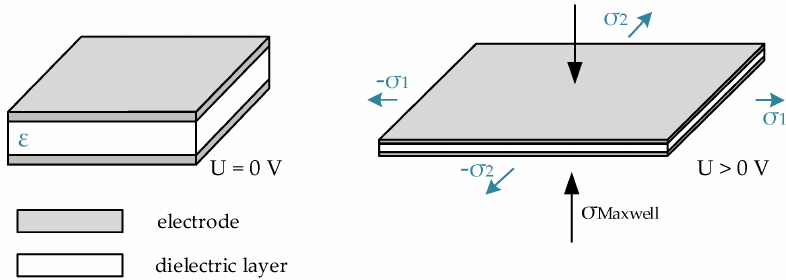
Figure 4. Principle of operation of the DEAP actuator (source: